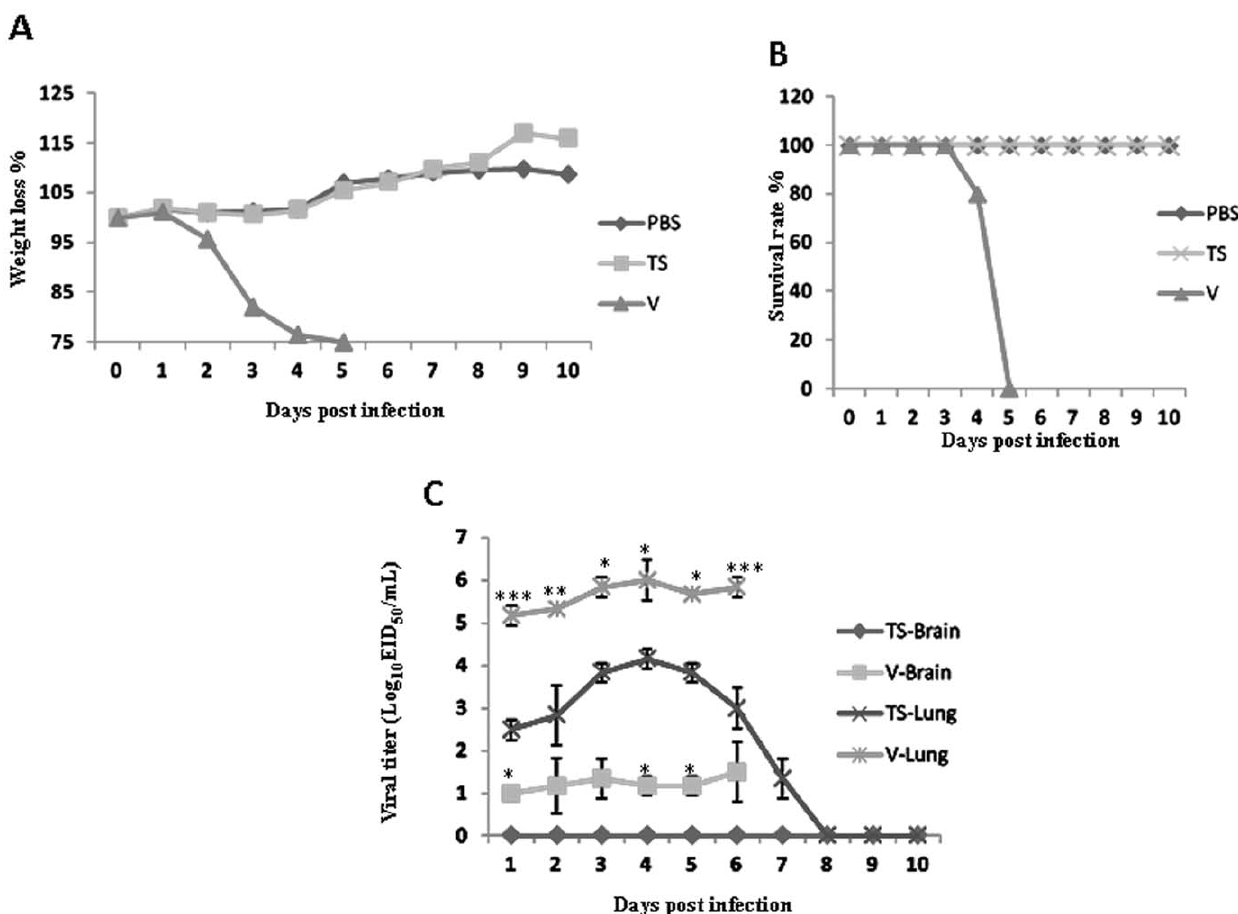
Figure 1. Weight changes, mortality and virus titers of mice inoculated with the TS and V virus. A) Weight changes of mice; B) Mortality of mice; C) Virus titers of the mouse lungs and brains: four-week-old SPF BALB/c mice (thirty mice/group) were inoculated intranasally with 10 6 EID 50 of each virus and three mice were euthanized on each day post infection and organ tissues were collected for virus titration in eggs. Data shown are the log 10 geometric mean EID 50 /ml 6 SEM; dashed line indicates detection limit of 10 1 EID 50 /ml.